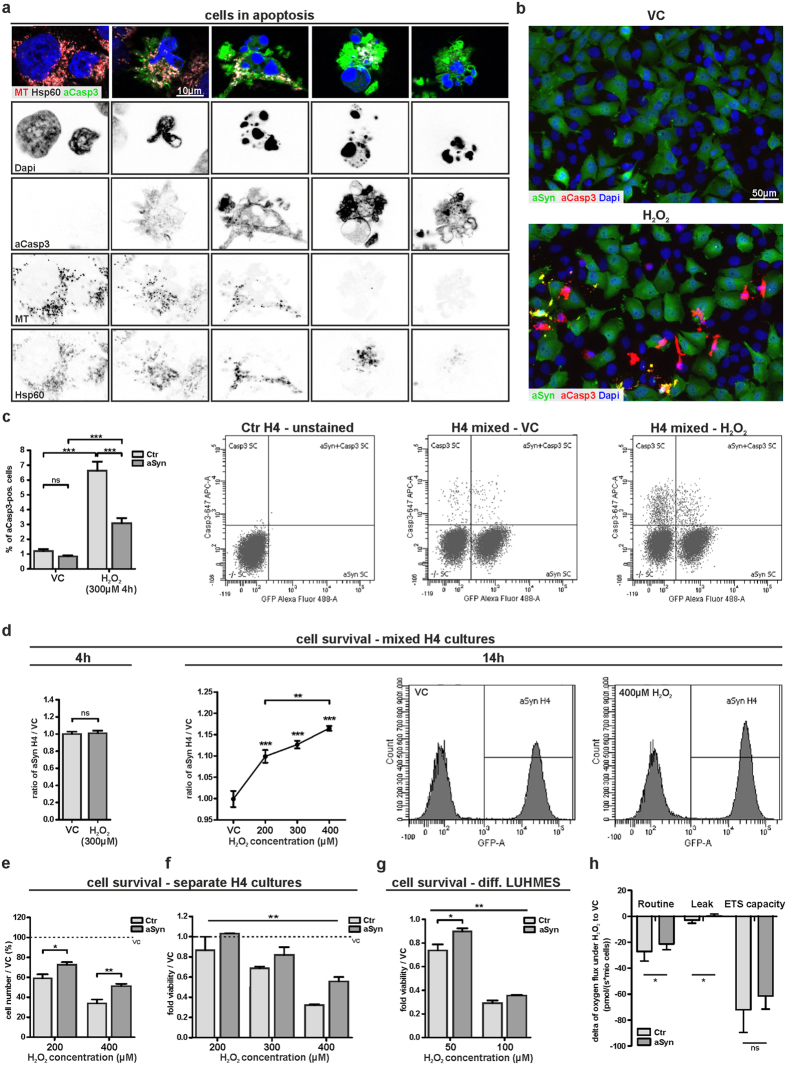
aSyn reduces Caspase3 activation and protects against oxidative stress.(a–c) H4 cells were treated with 300 μM H2O2 for 4 h. (a) aCasp3 as well as mitochondria (Hsp60 and MT) were visualized in different stages of apoptosis. (b,c) The assessment of Casp3 activation in a mixed culture of aSyn and Ctr H4 cells via immunocytochemistry (b) and flow cytometry (c) revealed that aSyn overexpression led to a reduction of H2O2-related Casp3 activation. (c) Two-way ANOVA (randomized block experiments) Bonferroni’s Multiple Comparison Test, n = 11, Ctr vs. aSyn: VC t = 1.471, H2O2 t = 14.68, DF = 20; Scatter blots representing GFP (aSyn H4) and aCasp3 (647) fluorescence signals of single cells (SC) as measured via flow cytometry are depicted. (d) The ratio of aSyn H4 cells after H2O2-treatment in comparison to VC-treated cells was analyzed in mixed cultured aSyn and Ctr H4 cells via flow cytometry. While there was no difference in the relative cell number of both cell populations 4 h after treatment with 300 μM H2O2, the ratio of aSyn H4 cells increased after 14 h with rising H2O2 concentrations (competitive survival assay (CSA), 4 h: unpaired two-tailed t-test, n = 11, p = 0.8514; 14 h: One-way ANOVA Tukey’s Multiple Comparison Test, n ≥ 6, F = 27.68, p < 0.0001). (e,f) The measurement of cell viability in separate cultures of aSyn and Ctr H4 cells 14 h after H2O2-treatment via cell counting (e, Two-way ANOVA Bonferroni’s Multiple Comparison Test, n = 4, F = 13.99, p = 0.0015 (Ctr vs. aSyn)) and MTT assay (f, Two-way ANOVA Bonferroni’s Multiple Comparison Test, n = 3, F = 9.221, p = 0.0079 (Ctr vs. aSyn)) revealed that aSyn H4 cells are more resistant to OS. (g) Ctr and aSyn LUHMES cells were treated with 50 or 100 μM H2O2 for 4 h. Analysis of cell viability via MTS assay showed that aSyn overexpression reduced the susceptibility to OS in LUHMES cells (Two-way ANOVA Bonferroni’s Multiple Comparison Test, n = 3, F = 12.87, p = 0.0071 (Ctr vs. aSyn)). (h) Oxygen consumption was measured in VC- or H2O2 (300 μM, 4 h)-treated Ctr and aSyn H4 cells. Delta of oxygen flux for H2O2-treated cells compared to control conditions is shown for Routine respiration, Leak respiration, and maximum respiration (electron transport system (ETS) capacity; unpaired two-tailed t-tests, n = 5, Routine: p = 0.0464; Leak: p = 0.0105, ETS: p = 0.1119).